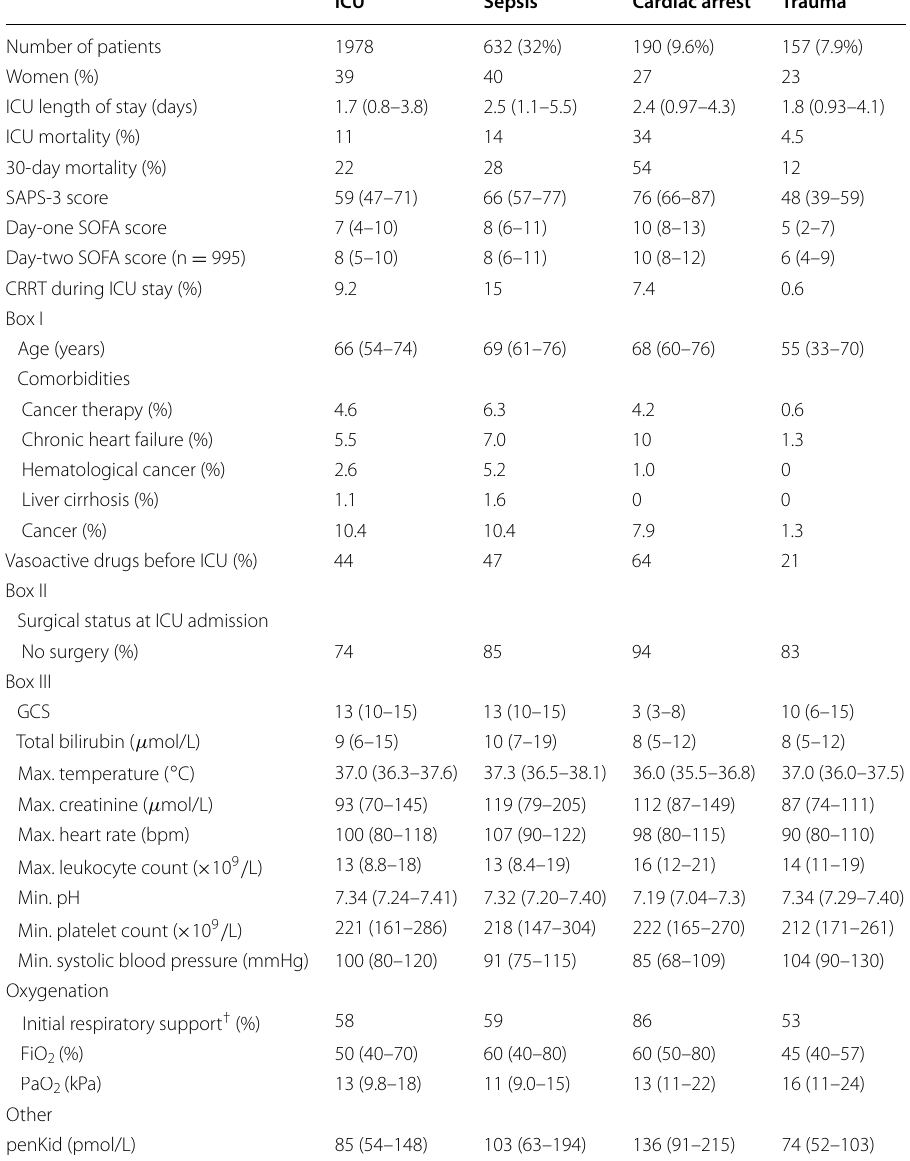
Table 1 Descriptive statistics for the whole ICU population, the sepsis-3 subgroup, the cardiac arrest subgroup and the trauma